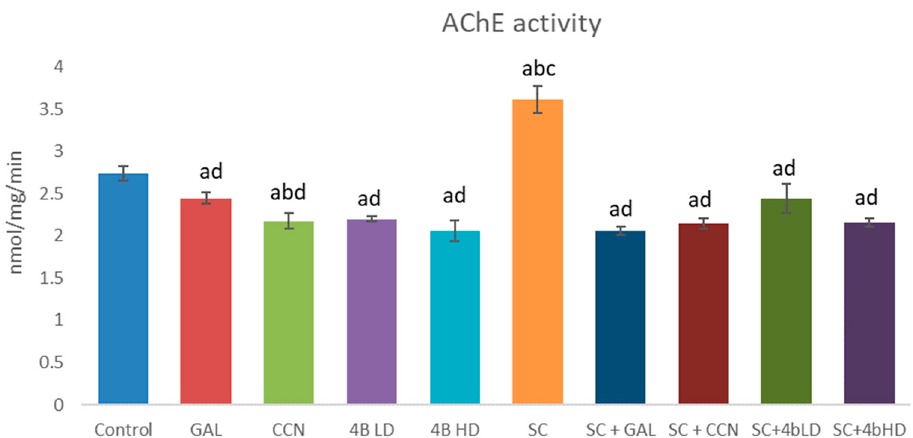
Figure 2. AChE activity measured over 10 min in brain homogenates from mice treated for 14 days with GAL, CCN and 4b (two doses) alone and in combination with SC. a p < 0.05 vs. control; b p < 0.05 vs. GAL; c p < 0.05 vs. CCN; d p < 0.05 vs. SC.